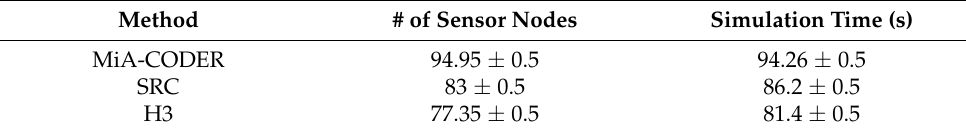
Table 6. Quantitative analysis of coverage